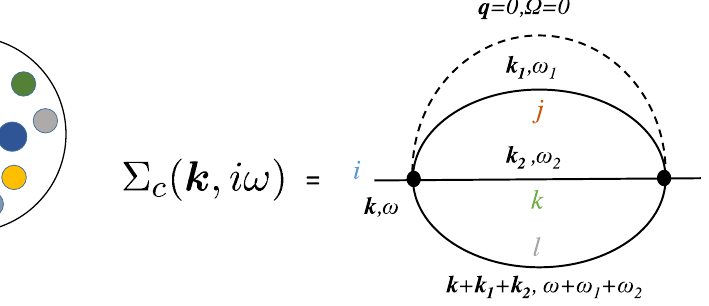
FIG. 1. (a) A two-dimensional lattice where each site contains N orbitals (represented by different colors). The hoppings, t c between any neighboring sites (colored arrows) are diagonal in orbital-index. Each site is identical and the system is transla- tionally invariant. (b) The internal structure of a single site with N orbitals. The on-site interactions, U c operators, with all orbital indices unequal.